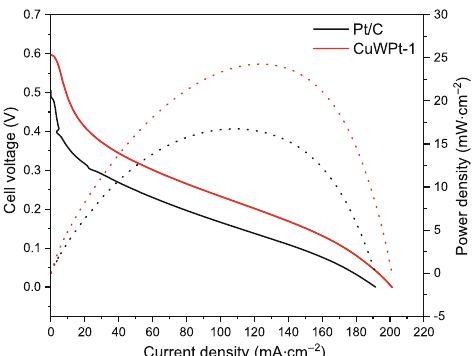
Figure 5 Polarization and power density curves of the assembled single DMFC with ternary CuWPt-1 and commercial Pt/C as anode catalysts working at 70 °C and atmospheric